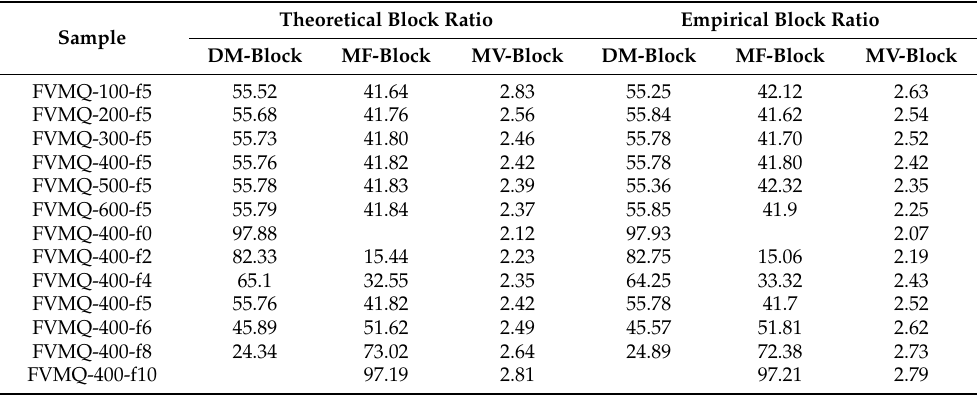
Table 3. Theoretical functional groups molar ratio and empirical molar ratio in FVMQs acquired from 1 H-NMR